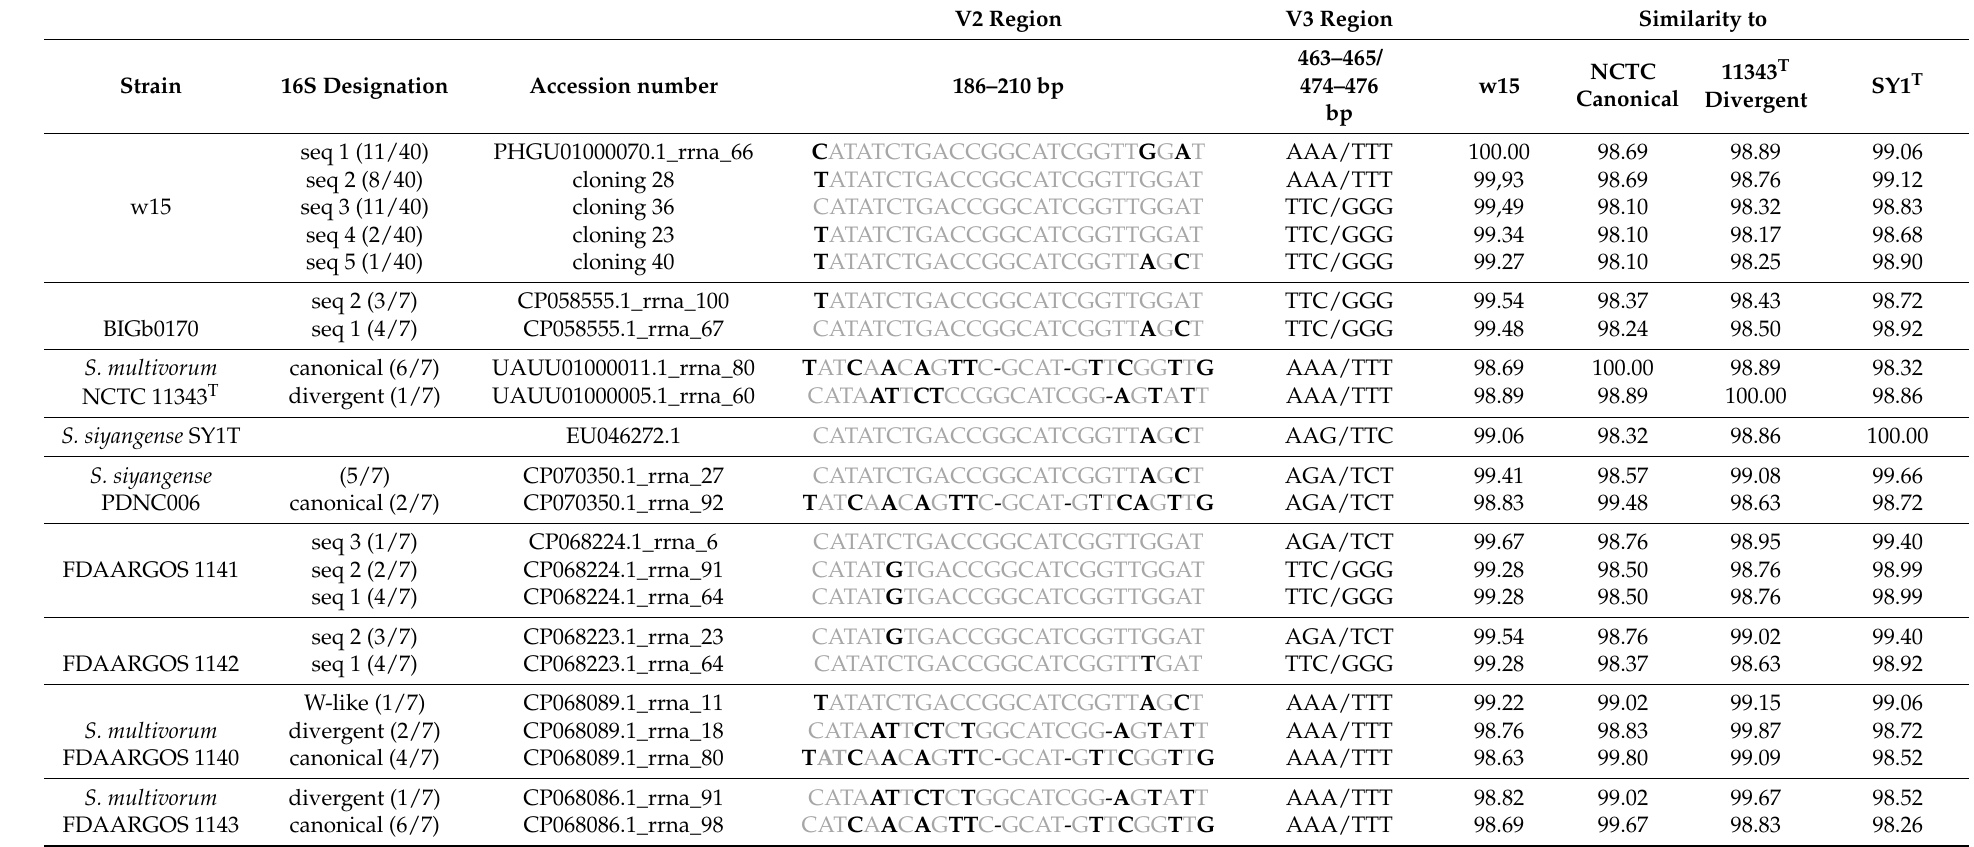
Table 4. 16S rRNA sequence similarities across Sphingobacterium strains, referring to w15